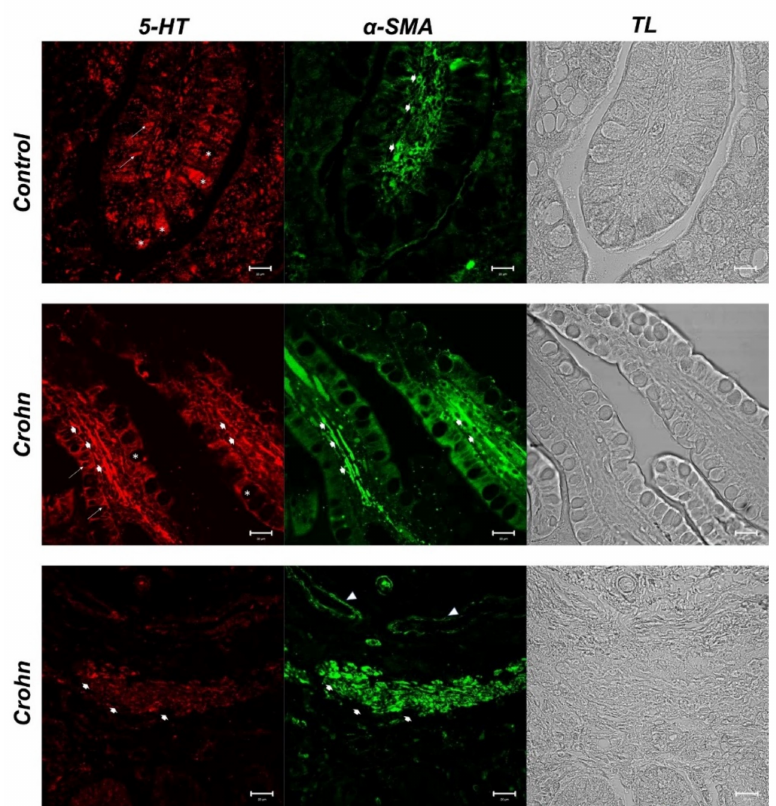
Figure 2. Human intestine. 5-HT and α -SMA, 20 × , scale bar 20 nm. In healthy intestine sections, red fluorescence evidenced serotonergic enteroendocrine cells (arrows) and the goblet cell cytoplasm (*). The positivity to α -SMA was observed in stromal cells (fibroblasts and mesenchymal cells) (large arrows). In CD samples, enterochromaffin cells (ECs), positive to 5-HT, were evident in the epithelium (arrows). Lamina propria cells with a high positivity to 5-HT were detectable (big arrows). The goblet cell cytoplasm was 5-HT negative (*). α -SMA positive cells in the lamina propria below the epithelium (large arrows). Blood vessels (arrowhead). The micrographs are also equipped with transmitted light (TL) to visualize the organ